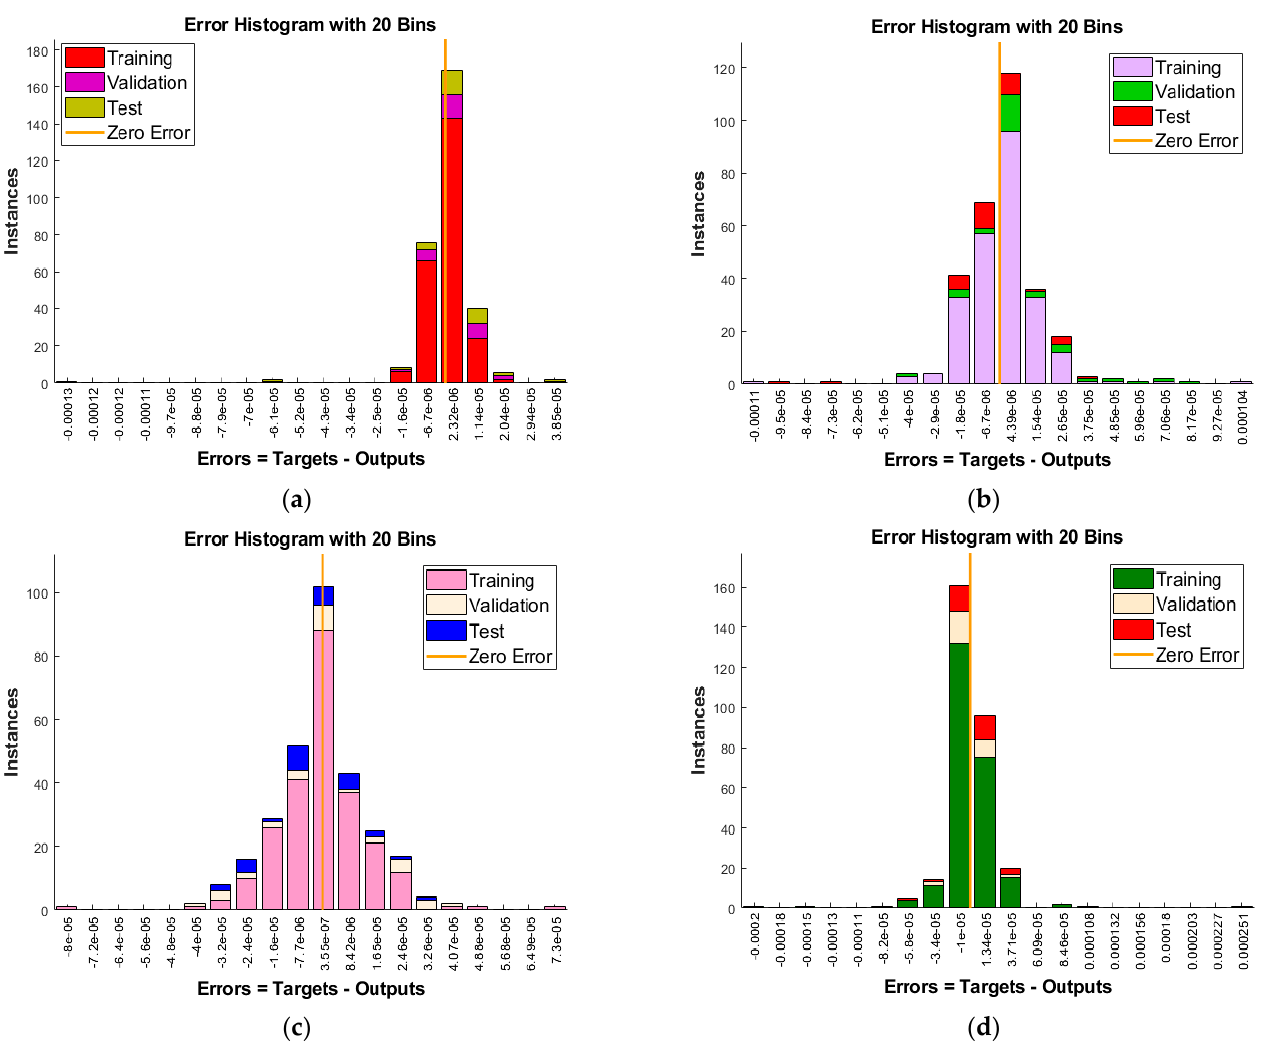
Figure ‒ 6. ( a – d ) Histograms for ANNLMB for each scenario of heat transfer in spinning nanofluid.